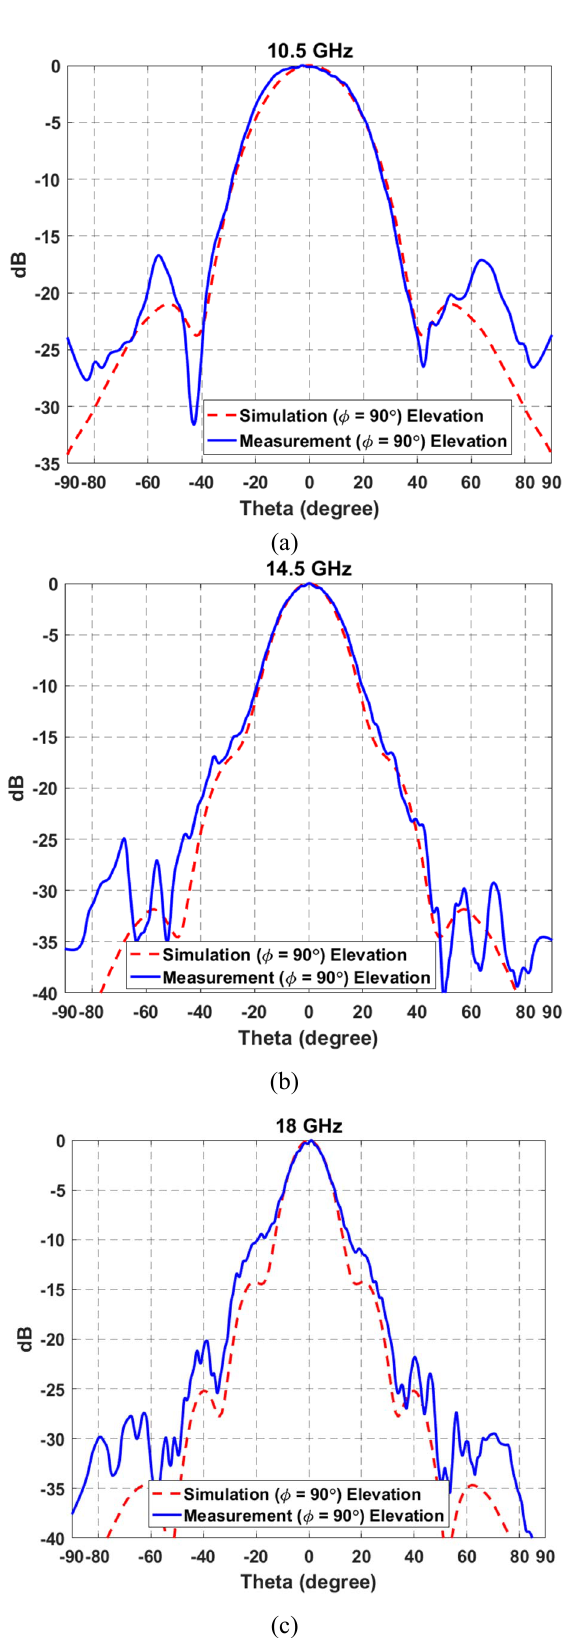
Figure 10: The measured and simulated (with PLA/nickel) co-polarization normalized patterns for H-plane (azimuth) at (a) 10.5 GHz (b) 14.5 GHz (c) 18